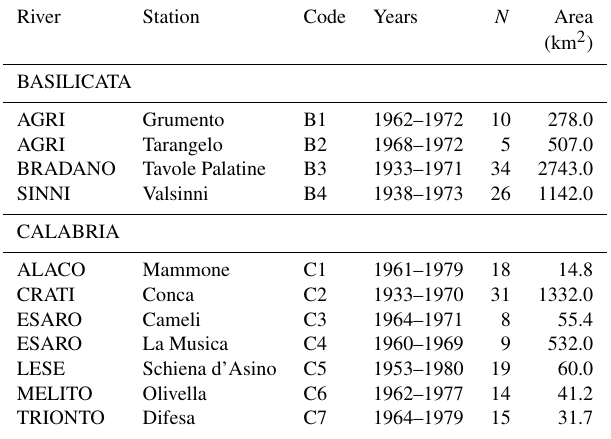
Table 1. Details of stream gauges and rivers considered in this